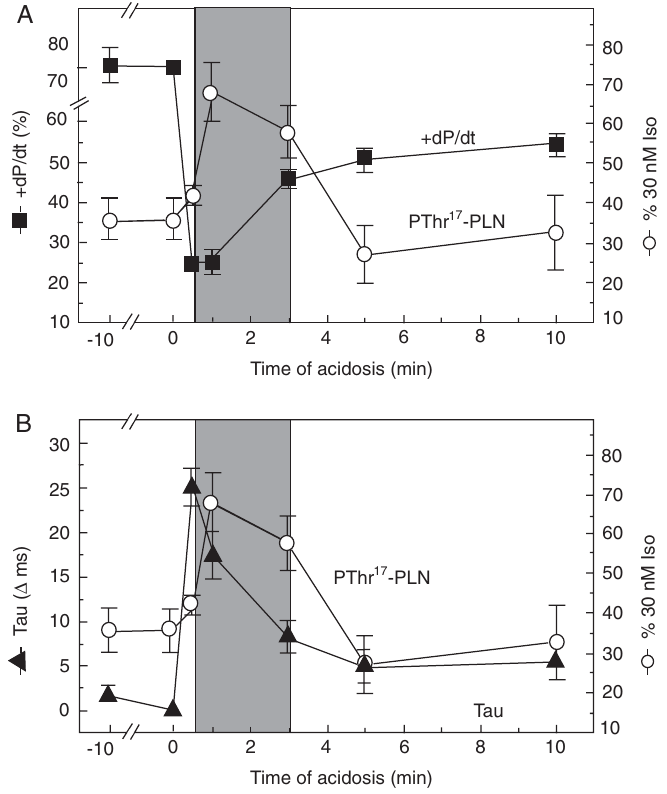
Figure 6. Effect of acidosis on left ventricular function and on the phosphorylation of Thr 17 of phospholamban (PLN). Hypercapnic acidosis produced an initial (30 s) decrease in con- tractility (maximal rate of rise in pressure, +dP/dt) (A) and an antirelaxant effect (prolonga- tion of the time constant of left ventricular developed pressure decay, Tau) (B), followed by mechanical recovery, most of which occurred during the first 3 min of acidosis. Phosphory- lation of the Thr 17 site of PLN increased simultaneously with the early recovery of contractil- ity and relaxation (A and B) and then returned to basal levels. Phosphorylation of Ser 16 remained at basal levels throughout the acidosis period (not shown). Phosphorylation of Thr 17 is reported as indicated in Figure 4C. +dP/dt is reported as percent of basal values. Tau is reported as ∆ ms of basal values. *P < 0.05 compared to basal values (Student t -test for paired (mechanical) or unpaired (biochemical) data). Modified from Ref. 20, with permis-